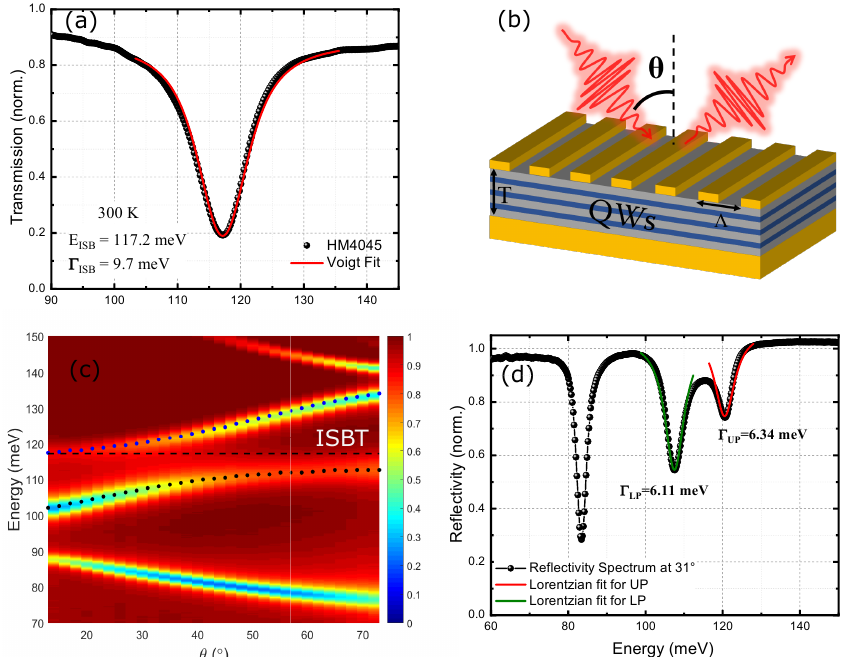
Figure 4. ( a ) Transmission spectrum at 300 K of the sample HM4045. The sample was grown with 120 s interruption time on the inverted interfaces. ( b ) The schematic of the cavity for operation in strong light matter coupling, and its angle-resolved measurement approach ( c ) The reconstructed angle-resolved dispersion of the HM4045 sample in the metal-metal cavity configuration. The lower and upper polaritons reflectivity minima are depicted in black and blue dots, respectively. The dashed black line shows the central frequency of the ISBT. ( d ) The reflectivity spectrum acquired at an angle of incidence of 31 ◦ (50%-50% light-matter fraction). The polariton linewidths are estimated using a Lorentzian fitting